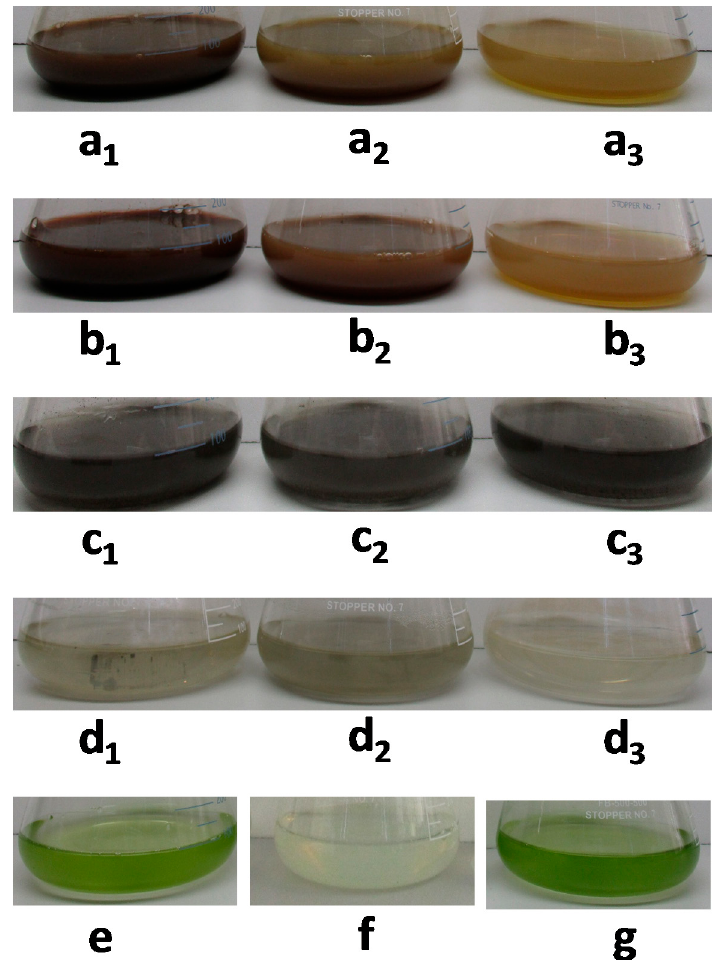
Figure 1. Photographic images after 2 h of cultivation: Erlenmeyer flasks containing AgNO 3 and ( a ) whole living cultures (WLC); ( b ) extracellular polysaccharide containing supernatant (EPS-S); ( c ) living cells fresh media (LCFM); and ( d ) Bold’s basal medium (BBM) (subscripts 1, 2, 3 denotes three different AgNO 3 final concentrations, that is, 1.250 mM, 0.625 mM and 0.125 mM, respectively). Also shown are the control Erlenmeyer flasks containing ( e ) WLC; ( f ) EPS-S; and ( g ) LCFM without AgNO 3 .